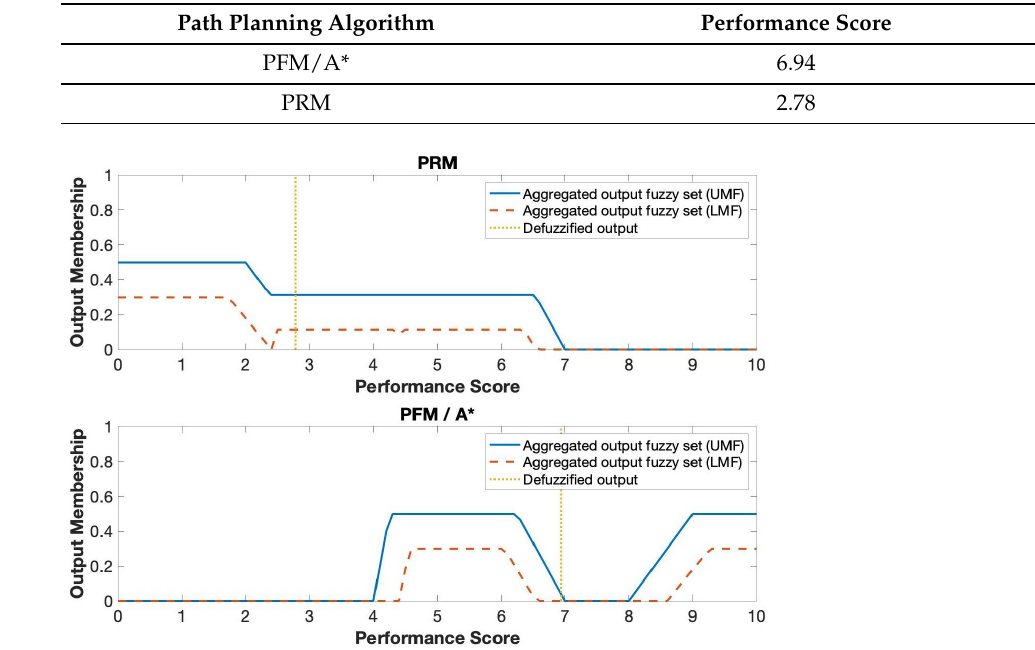
Figure 24. Output set for Case Study